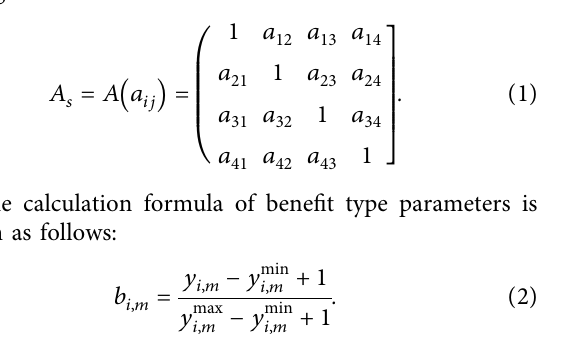
Figure 7: Route unidirectional neural chain